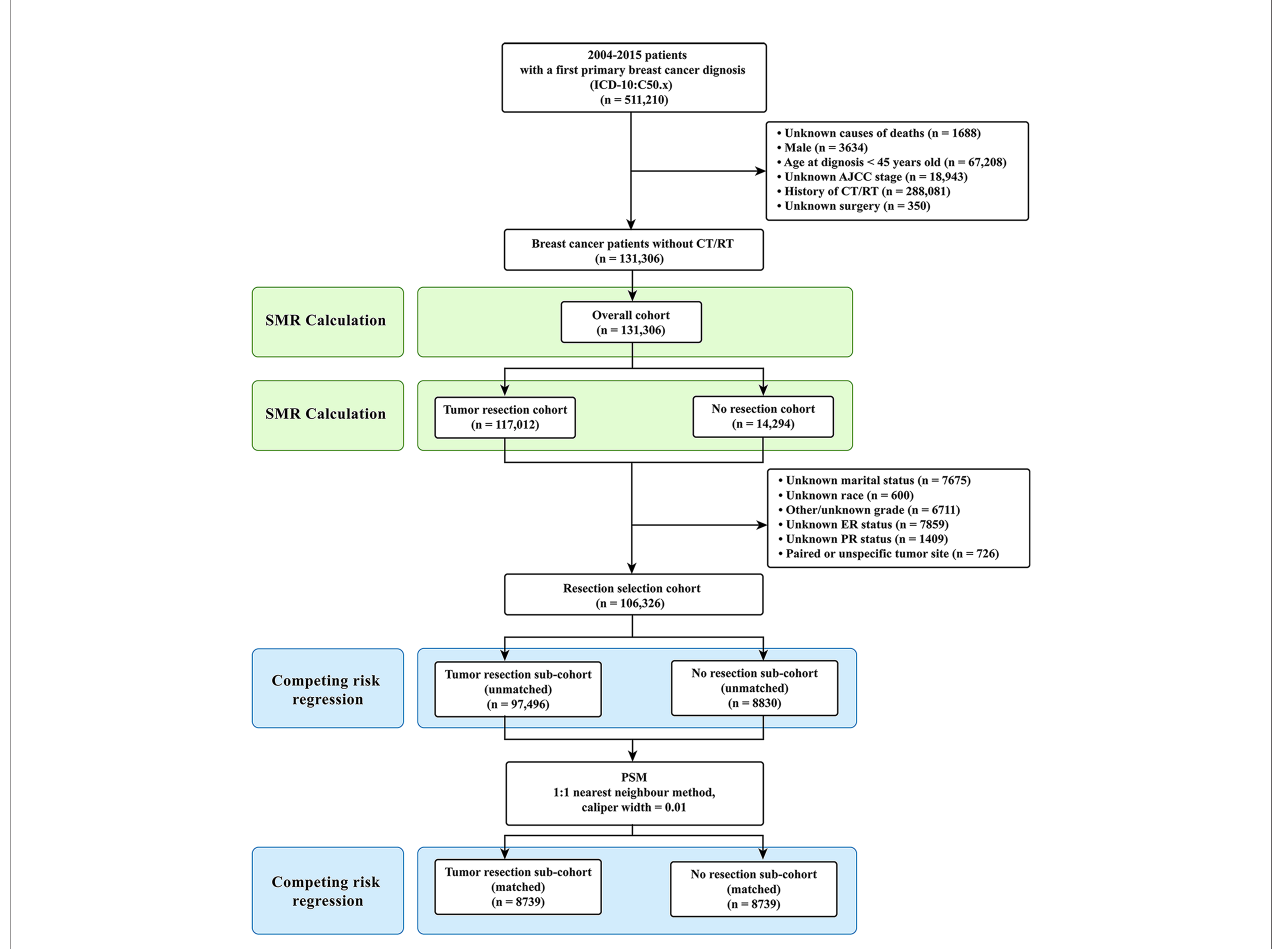
FIGURE 1 | Selection of eligible patients and study design. CVD, cardiovascular death; SMR, standardized mortality